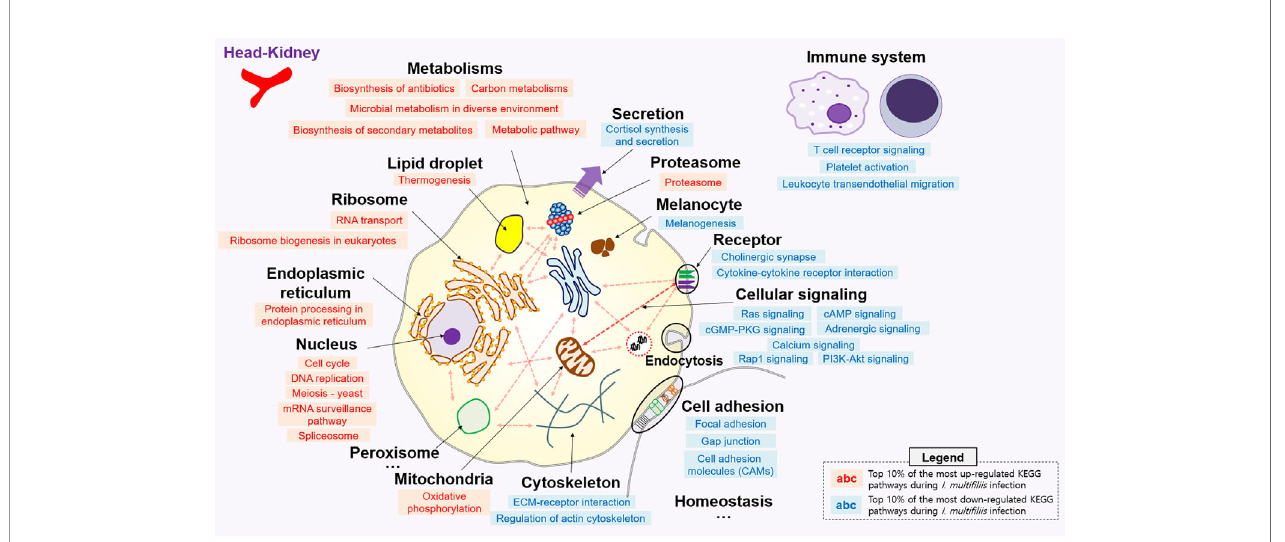
Transcriptomic Responses in the Head Kidney and Liver Under I. multi fi liis Infection and Recovery In order to investigate the shared and independent DEGs and pathways between organs during I. multi fi liis infection and recovery, the co-expressed pathways and DEGs were pro fi led. For the Ich and R-Ich groups, pathways with positive Z-scores in both the head kidney and liver were classi fi ed as PO-PO, while pathways with negative Z-scores in both organs were considered NE-NE. Likewise, pathways with a negative Z-score in the head kidney but a positive Z-score in the liver were classi fi ed as NE- PO, and pathways where Z-score > 0 and Z-score < 0 in the head kidney and liver, respectively, were called PO-NE ( Figure 4 and